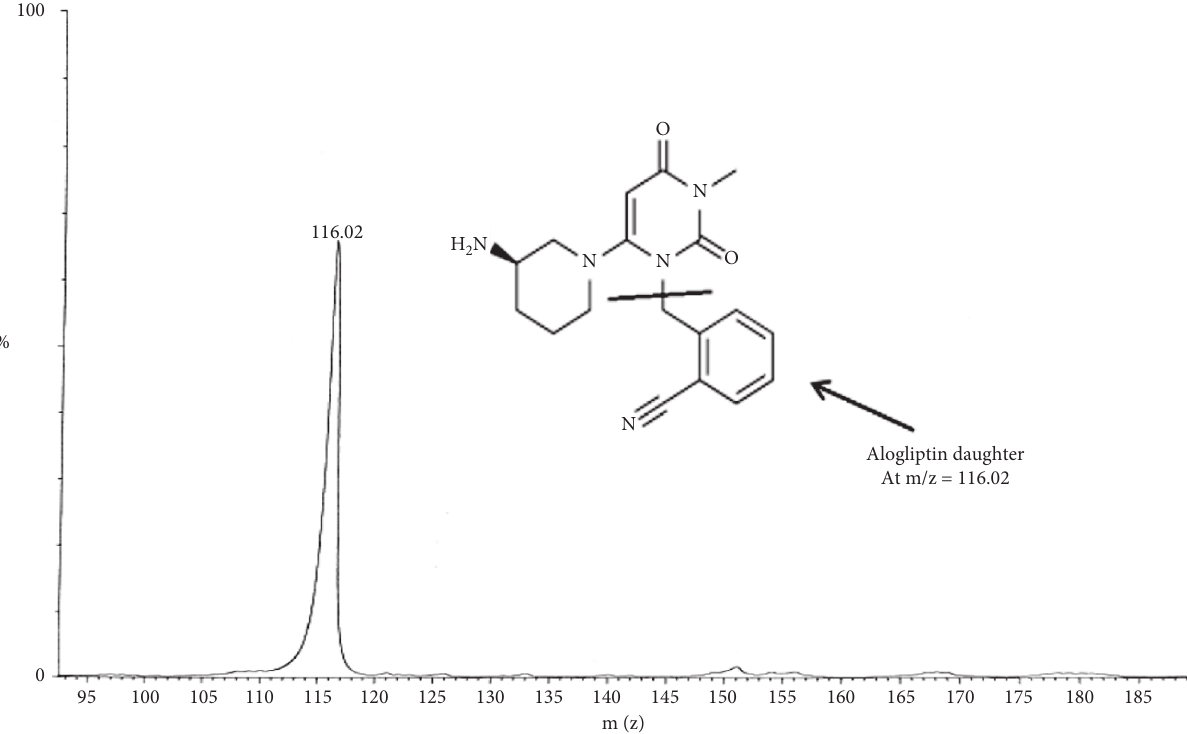
Figure 4: IS daughter ions (+ESI) at m/z �